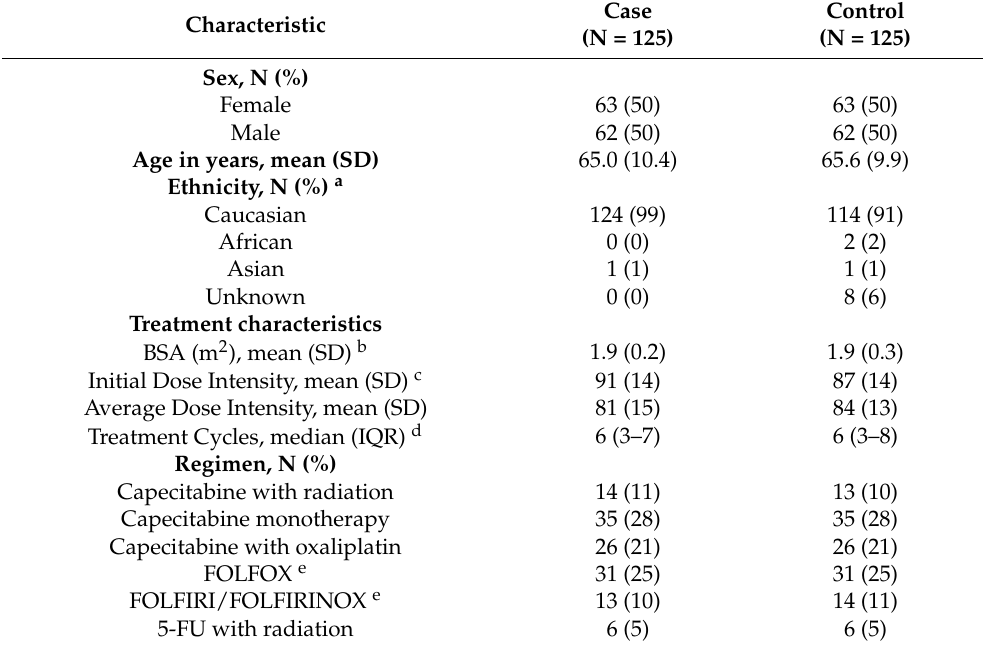
Table 1. Baseline